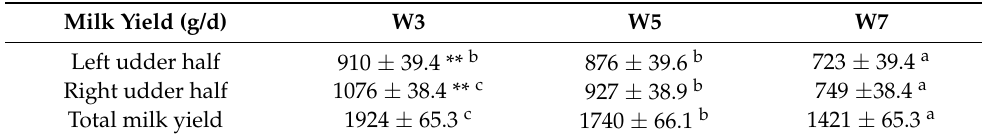
** Daily milk yield of the right udder half differed from milk yield of the left udder half ( p < 0.01); a,b,c Within rows, means with different superscripts are significantly different ( p < 0.05).